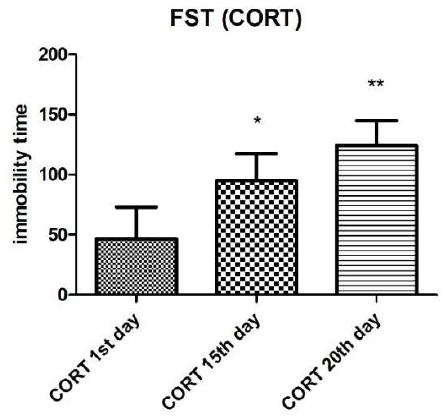
Figure 2. CORT immobility time in the forced swimming test (FST). Values are expressed as mean ± SEM ( n = 10). Statistical analysis was determined by one-way ANOVA followed by the Student-Newman-Keuls test. Significant values: * p < 0.05, ** p < 0.001 vs. CORT 1st day.